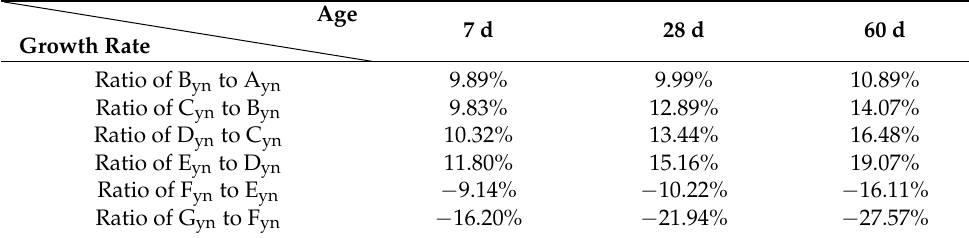
Table 5. Growth Rate of Peak Dynamic Stress of Ni-Fe Slag Powder Soil Cement. Growth